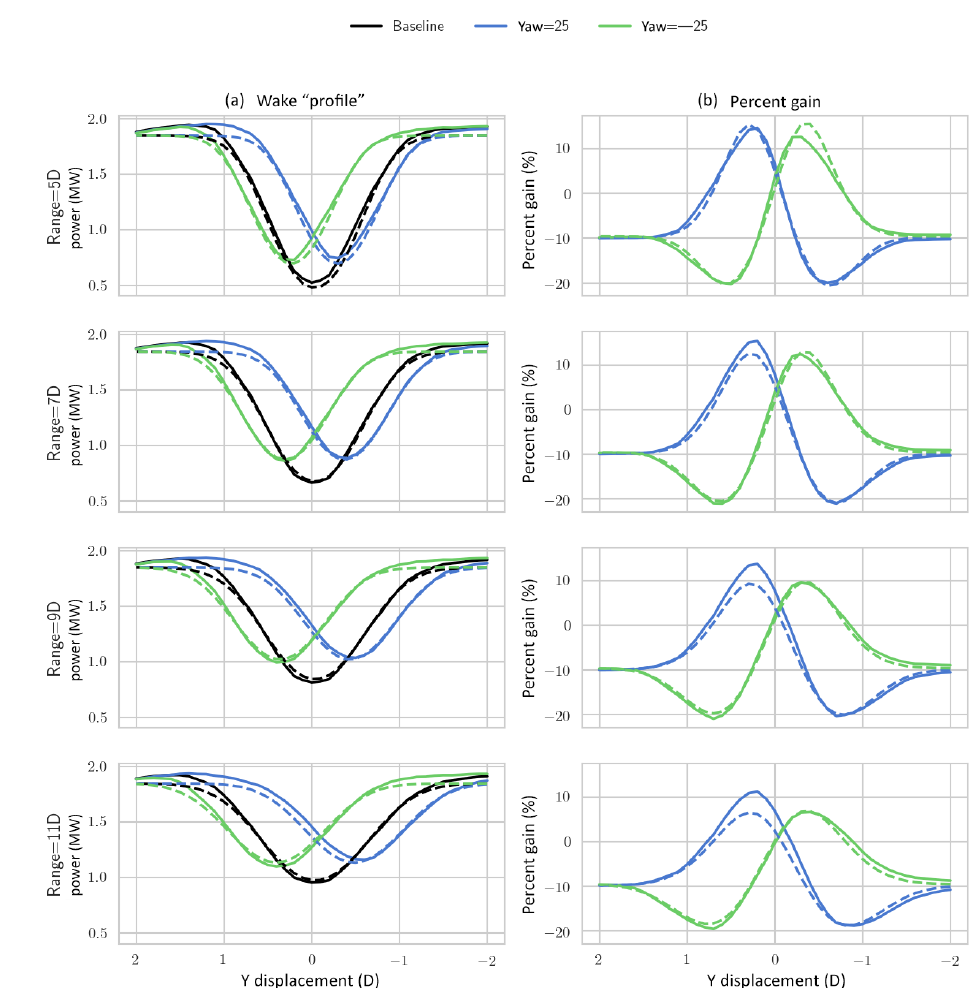
Figure 4. Power output of hypothetical downstream turbine for various downstream distances and lateral offsets (a) . Solid lines are SOWFA results, and dashed are from FLORIS. (b) The percent gain (of the total power of the actual and hypothetical turbine) is shown relative to the baseline of the two yaw angles.